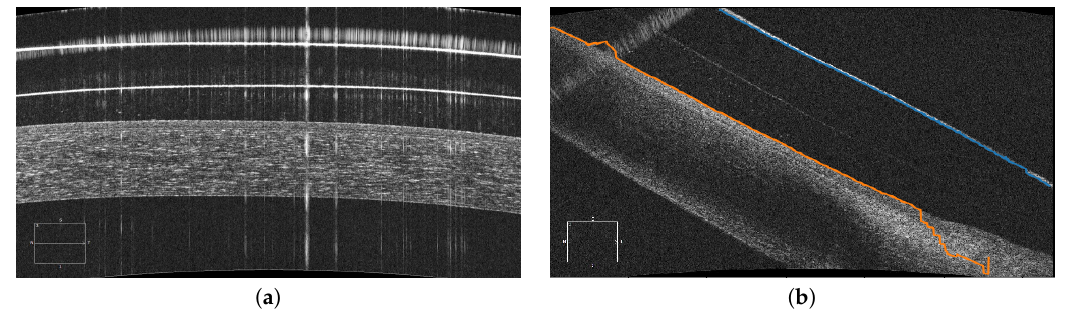
Figure 16. Examples of difficulties in the analysis of AS-OCT images. ( a ) Image with a high level of noise that hinders the normal processing. ( b ) Case where the inner line of the SCL does not present enough contrast.